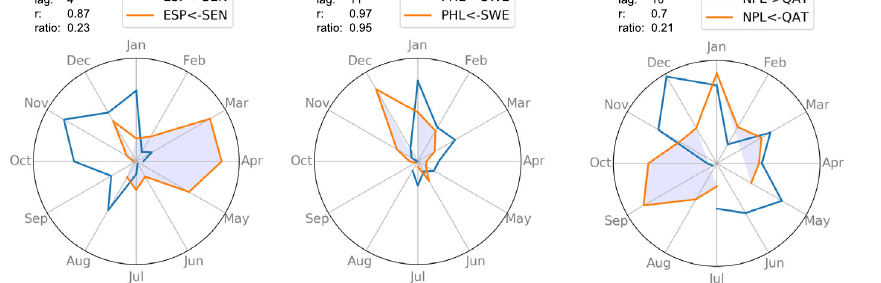
months are now during the spring of the southern hemisphere